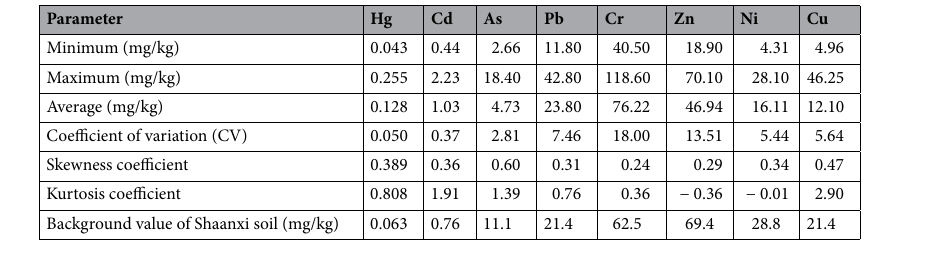
Table 5. Statistics of contents of heavy metals in wasteland soil (n =